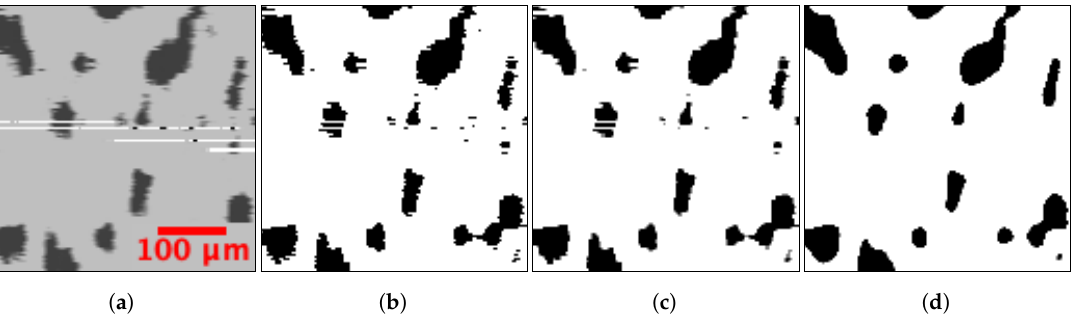
Figure 14. Comparison of different amounts of median filtering applied to the same synthesized image volume for the Berea sandstone model: images are taken from the x − z plane of a generated image volume. As the size of the spherical median filter is increased, there is less jittering between image slices and undefined pixels are eliminated, but smaller details are lost. ( a ) Original; ( b ) Binary; ( c ) r = 1; ( c ) r =